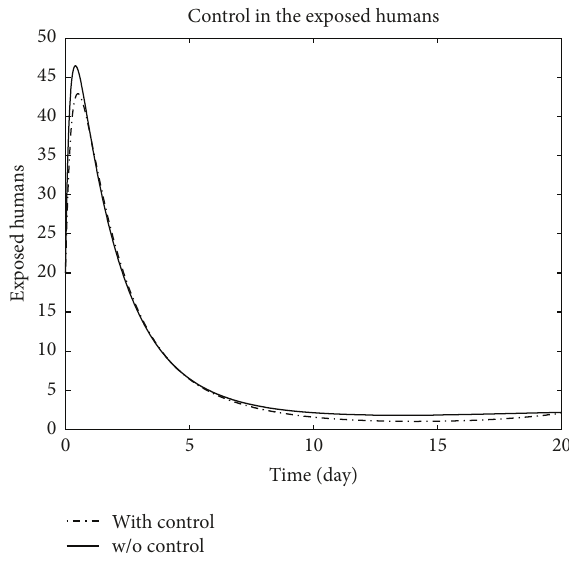
Figure 2: The plot represents the population of exposed humans with and without control.